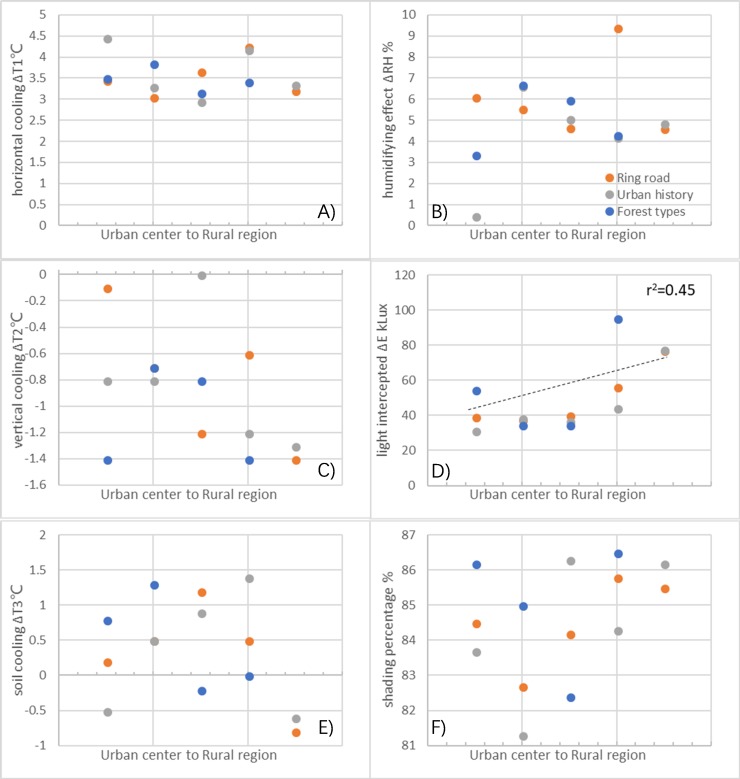
Differences of microclimate regulation variations in trees from three urban-rural gradient regions.(A) Horizontal cooling; (B) humidifying effect; (C) vertical cooling; (D) light interception amount; (E) soil cooling; (F) shading percentage. Dashed line in the figures indicates significant change in the regression analysis (p < 0.05).